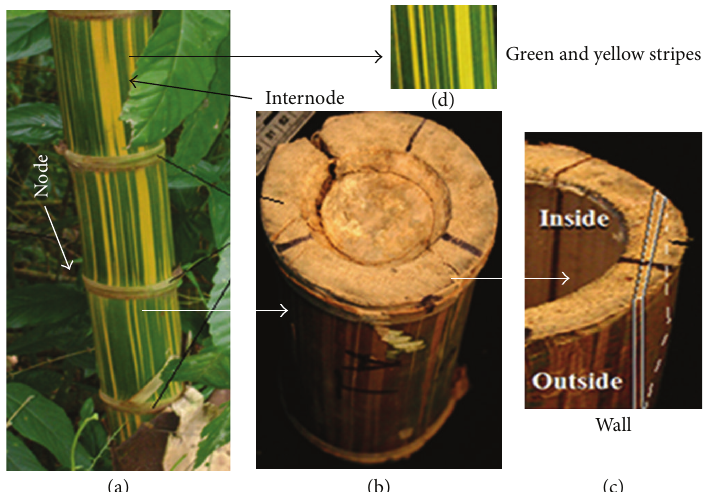
Figure 1: Guadua angustifolia Kunth variety Bicolor: (a) nodes and internodes, (b) culm, and (c) outside and inside GAKVB